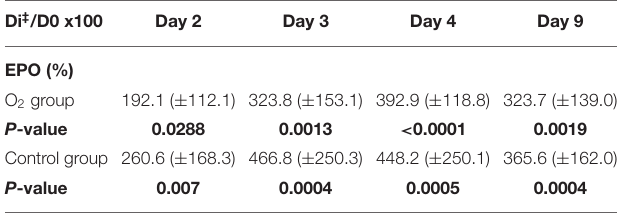
TABLE 3 | Percentage EPO expressed as mean ( ± SD * ) for each group with respect to baseline value (D0 † ) at different days across the study period (ANOVA